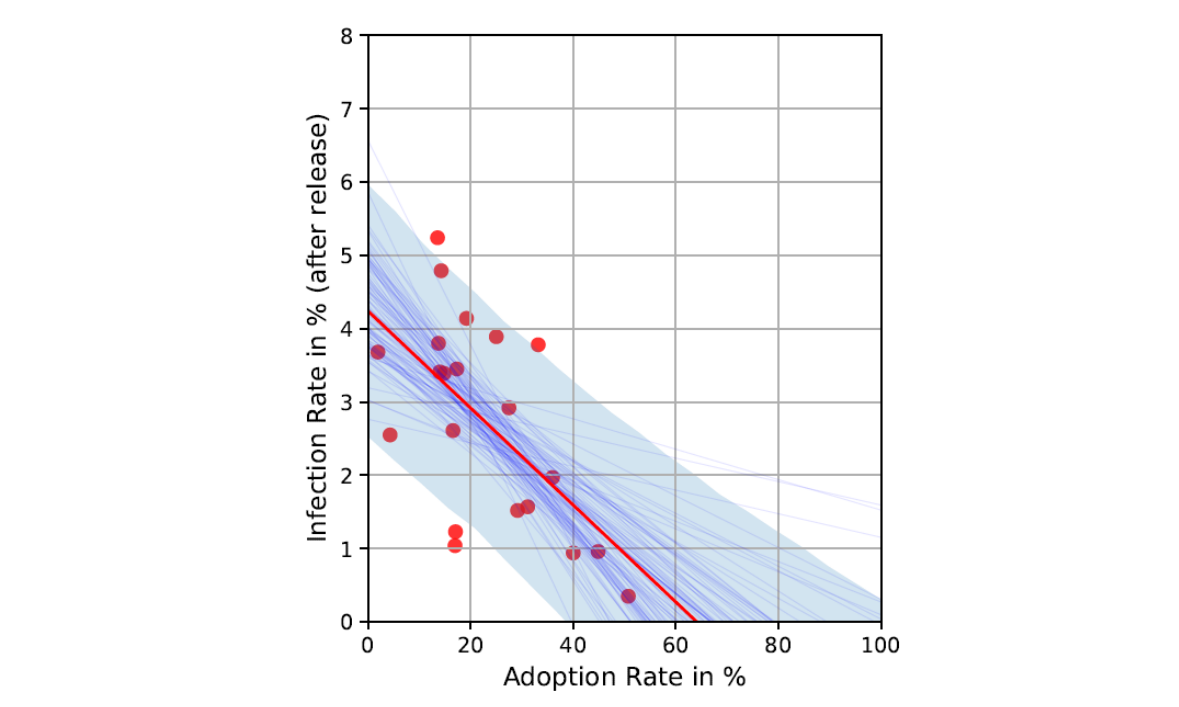
Table 1)—provided best practice